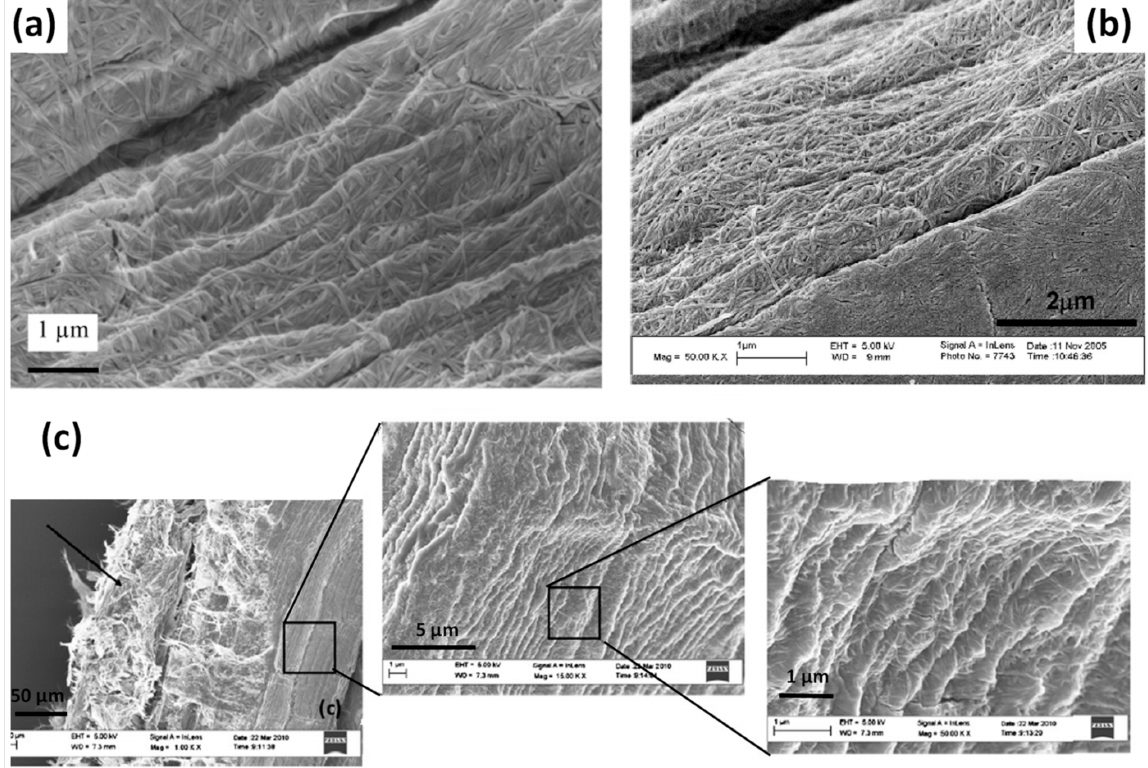
Figure 17. SEM images of ( a ) hemp fibres coated by BC, ( b ) sisal fibres coated by BC and ( c ) “hairy” short sisal fibres coated by BC (reprinted with permission from Pommet et al., 2008 [28], Juntaro et al., 2007 [84] and Lee et al., 2012